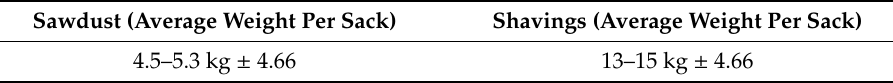
Table 4. Waste in kilograms generated per day.